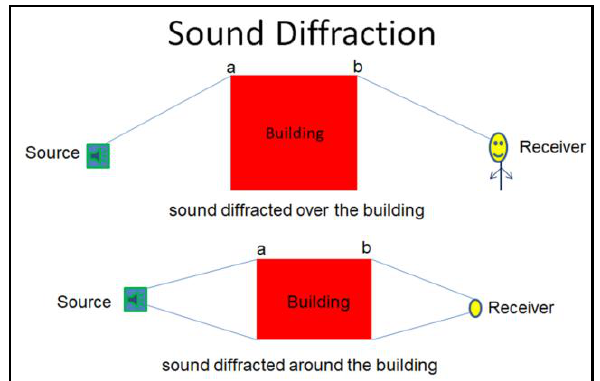
Figure 1. Sound diffraction